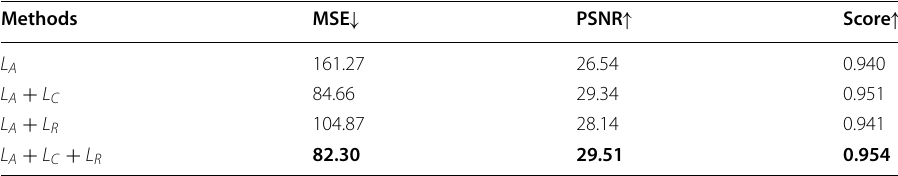
Bold values indicate the best results Table 4 Result comparison on SHU dataset with different values of the key parameter (cid:31) 1 (cid:31) 1